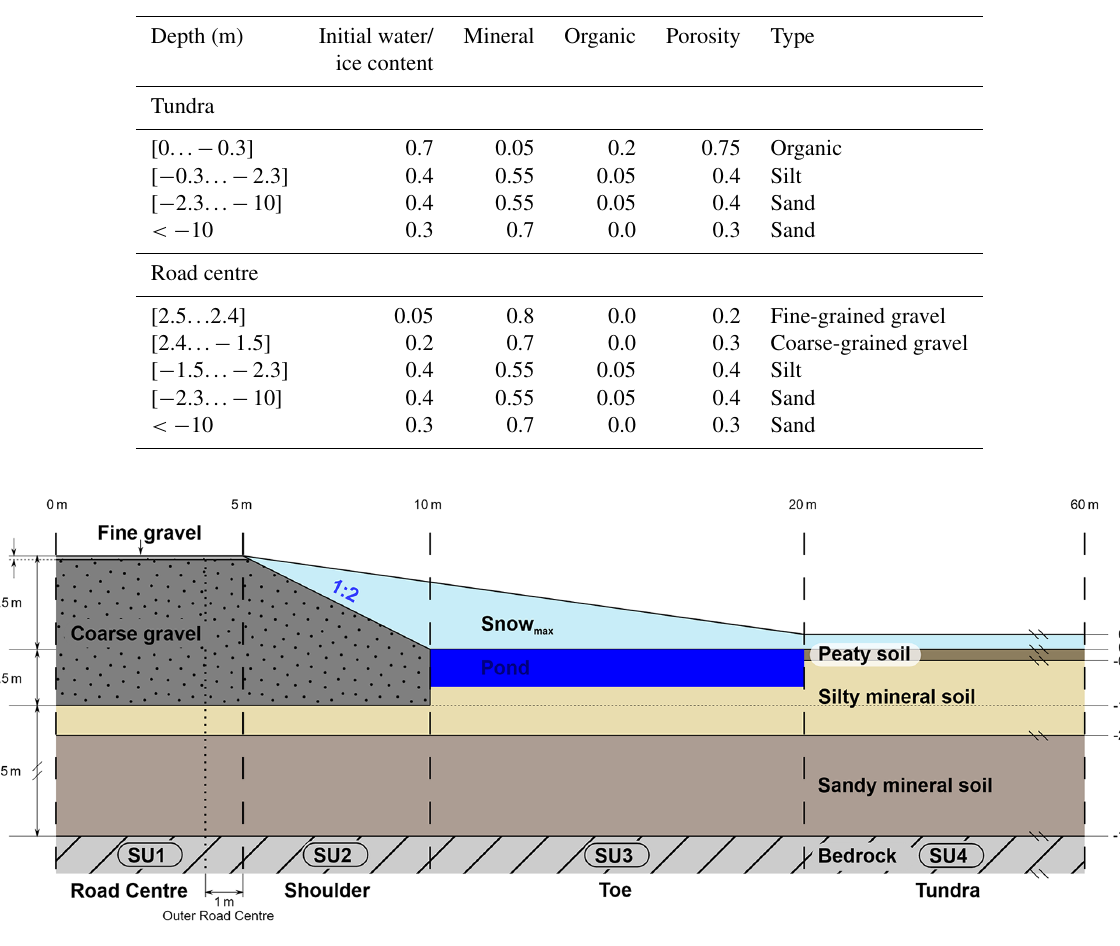
Figure 3. Modelled half cross section from the road centre to the adjacent tundra. The setting shown illustrates the subdivision into four structural units (SU1-4: Road Centre (including the additional tile for resolving the outer edge), Shoulder, Toe, Tundra). The greyish area with black dots represents the road embankment. The light blue shading indicates potential maximum snow height. The dark blue area illustrates ponding next to the road. The lower model boundary (not shown) is at 1000m